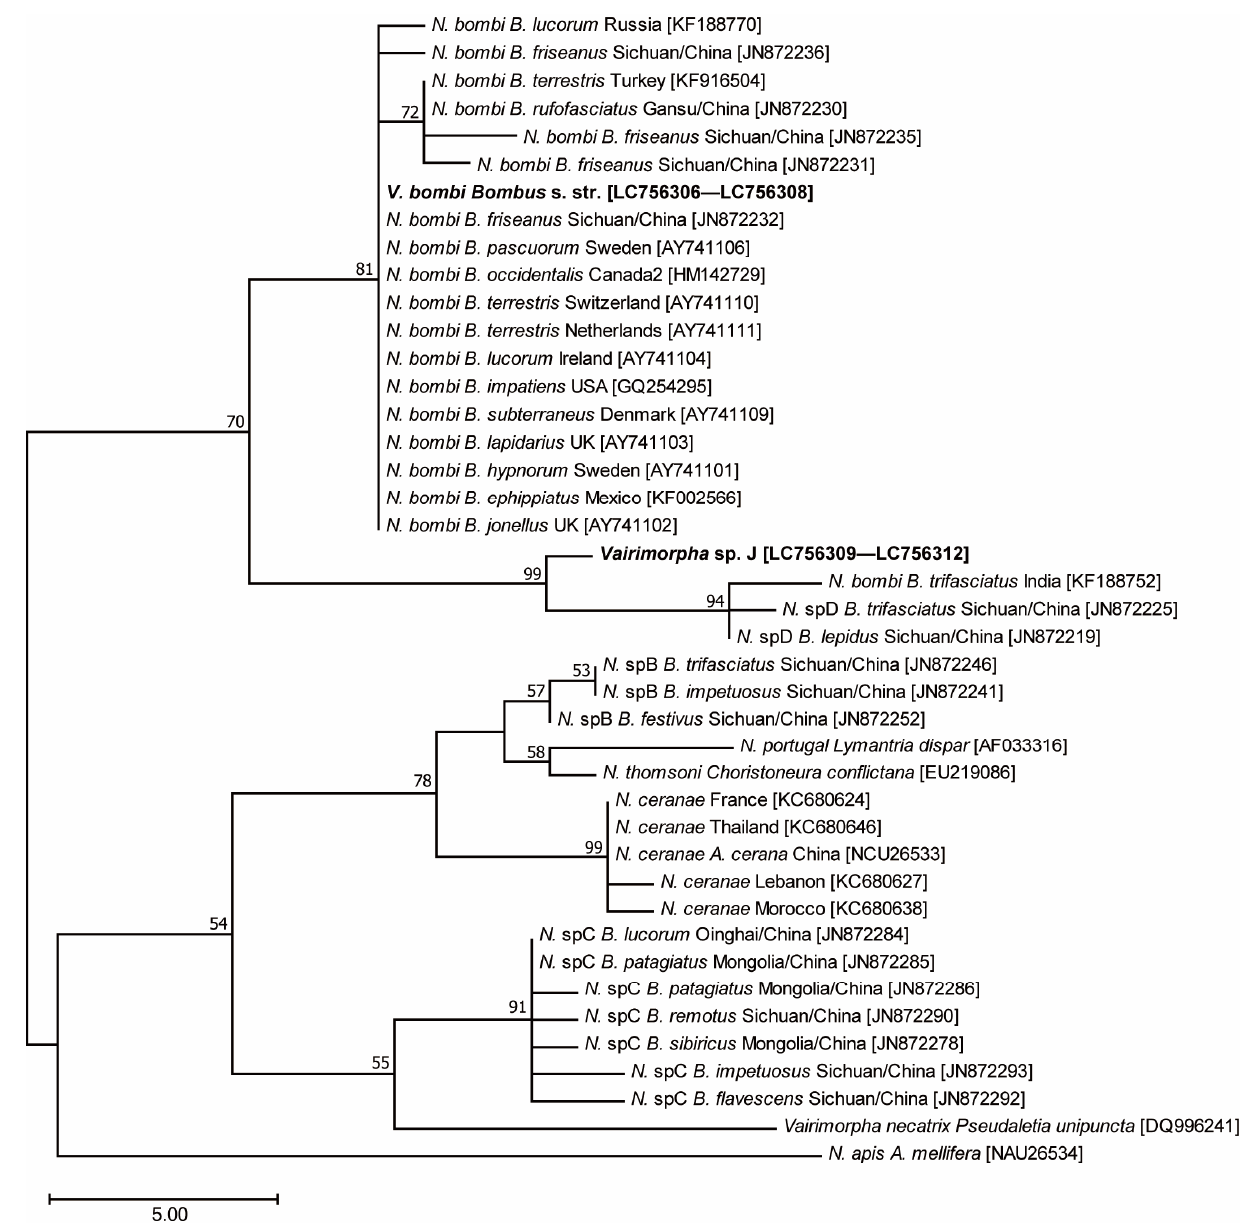
Figure 5. Maximum parsimony of the relationships among Vairimorpha spp. Samples collected from Hokkaido and Honshu based on alignments of the SSUr RNA gene. Bootstrap values exceeding 50% are shown (1000 replicates). The names indicate Vairimorpha spp., host names, collection site, and GenBank accession numbers were in square brackets.